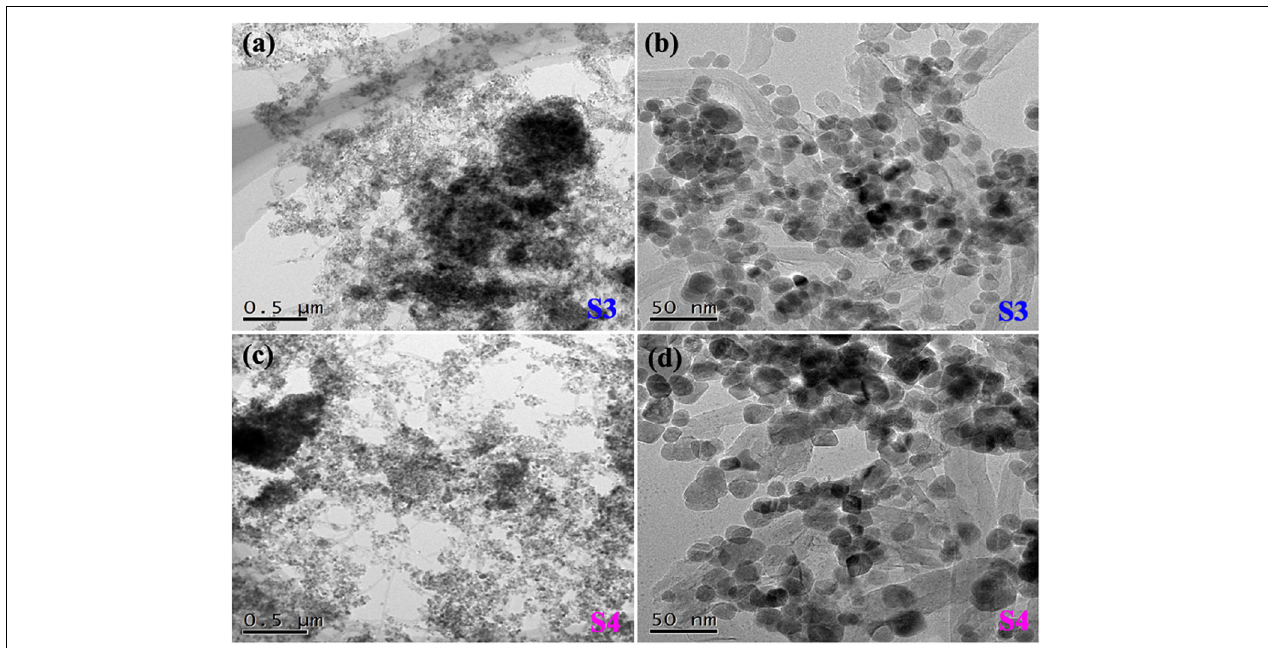
FIGURE 6 | TEM images of (a,b) S3, and (c,d) S4,